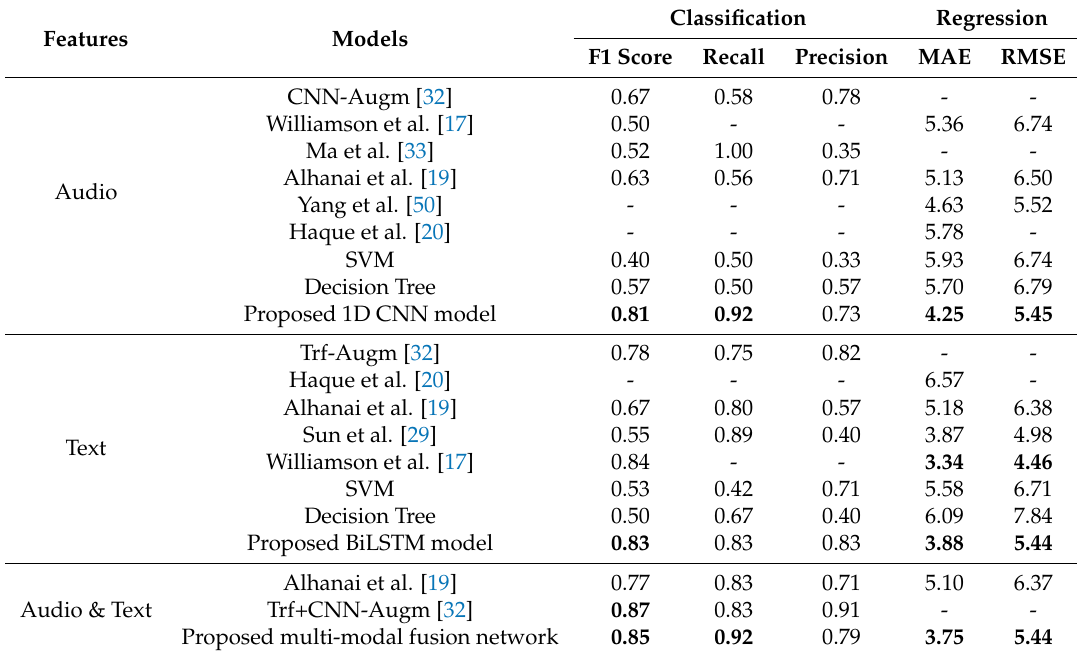
Results of the experiments on the Distress Analysis Interview Corpus Wizard-of-Oz (DAIC-WoZ)